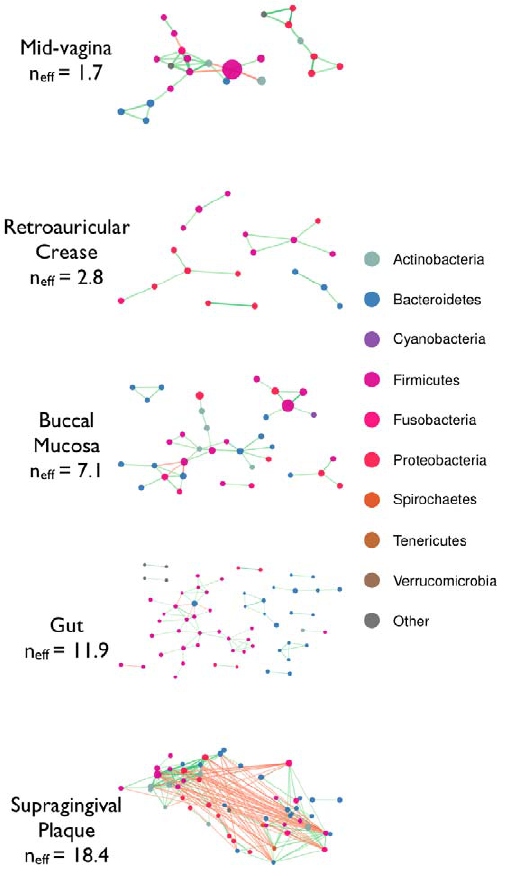
Figure 4. HMP correlation networks inferred using SparCC. Networks inferred using SparCC from the same data as in Fig. 1 (see Fig. S2 for SparCC networks of all HMP body sites). No correlations with magnitude greater than the 0.3 cutoff were inferred from the shuffled data (not shown). Nodes represent OTUs, with size reflecting the OTU’s average fraction in the community, and color corresponding to the phylum to which the OTU belongs. Edges between nodes represent correlations between the nodes they connect, with edge width and shade indicating the correlation magnitude, and green and red colors indicating positive and negative correlations, respectively. For clarity, only edges corresponding to correlations whose magnitude is greater than 0.3 are drawn, and unconnected nodes are omitted. See Fig. S6 for all 18 HMP body sites.